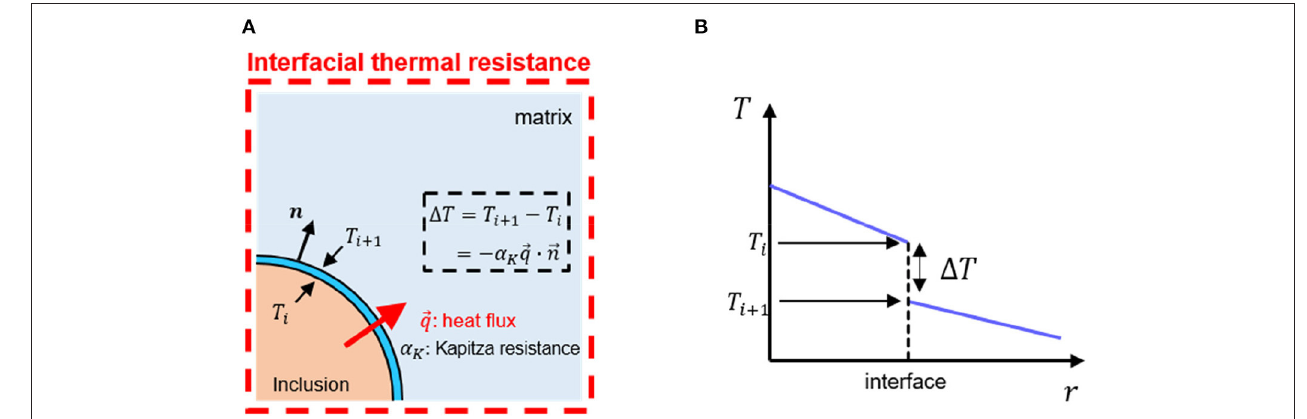
FIGURE 7 | (A) Schematic of the Kapitza resistance at the interface, and (B) temperature jump across the interface.